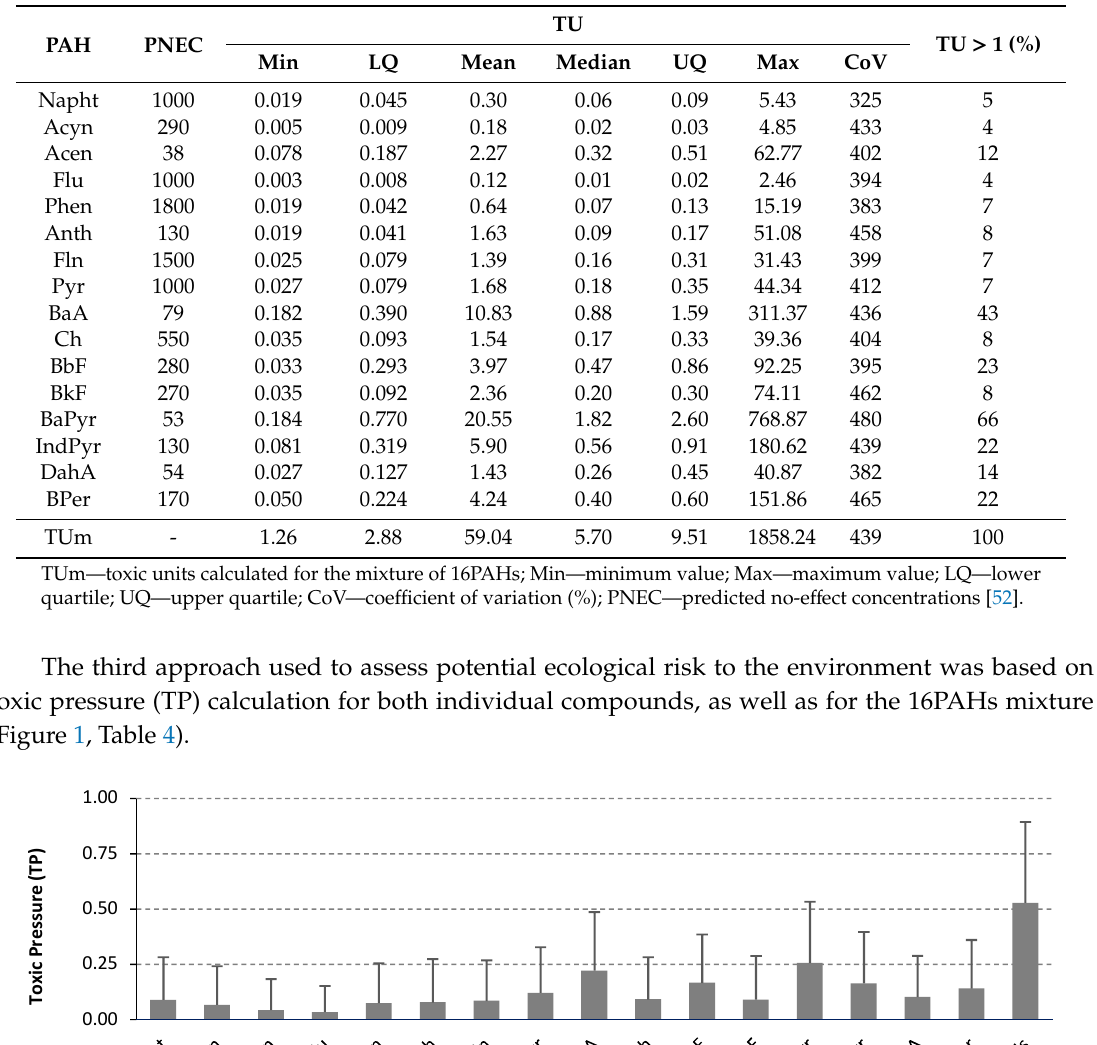
Table 3. Descriptive statistics of toxic units (TU) for individual PAH compounds and the predicted no e ff ect concentrations (PNEC, µ g kg − 1 ) used for TUs calculation; additionally, percentage of soil samples with TU and TUm > 1 was shown.